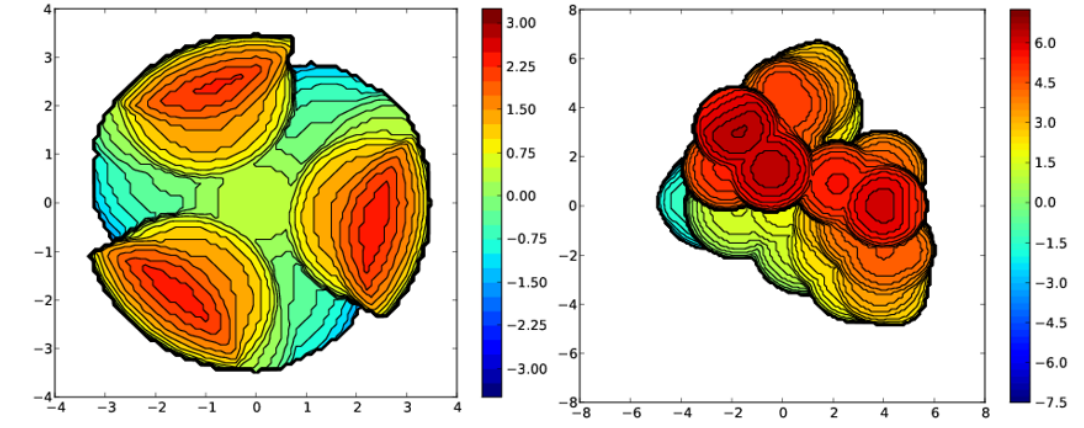
Figure 8. Steric maps of HTptm (left) generated with a coordination sphere of 3.5 Å and HTptm CF3 (right), generated with a coordination sphere of 7.5 Å to give a more representative image.